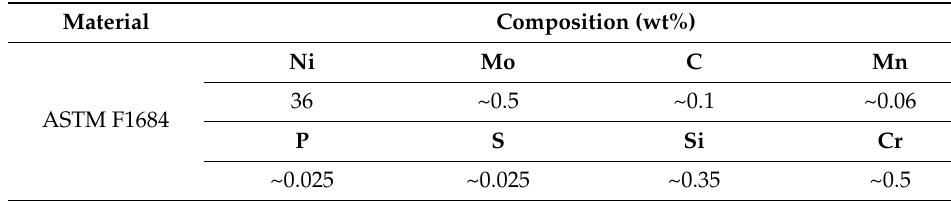
Table 1. Chemical composition of ASTM F1684 [21].